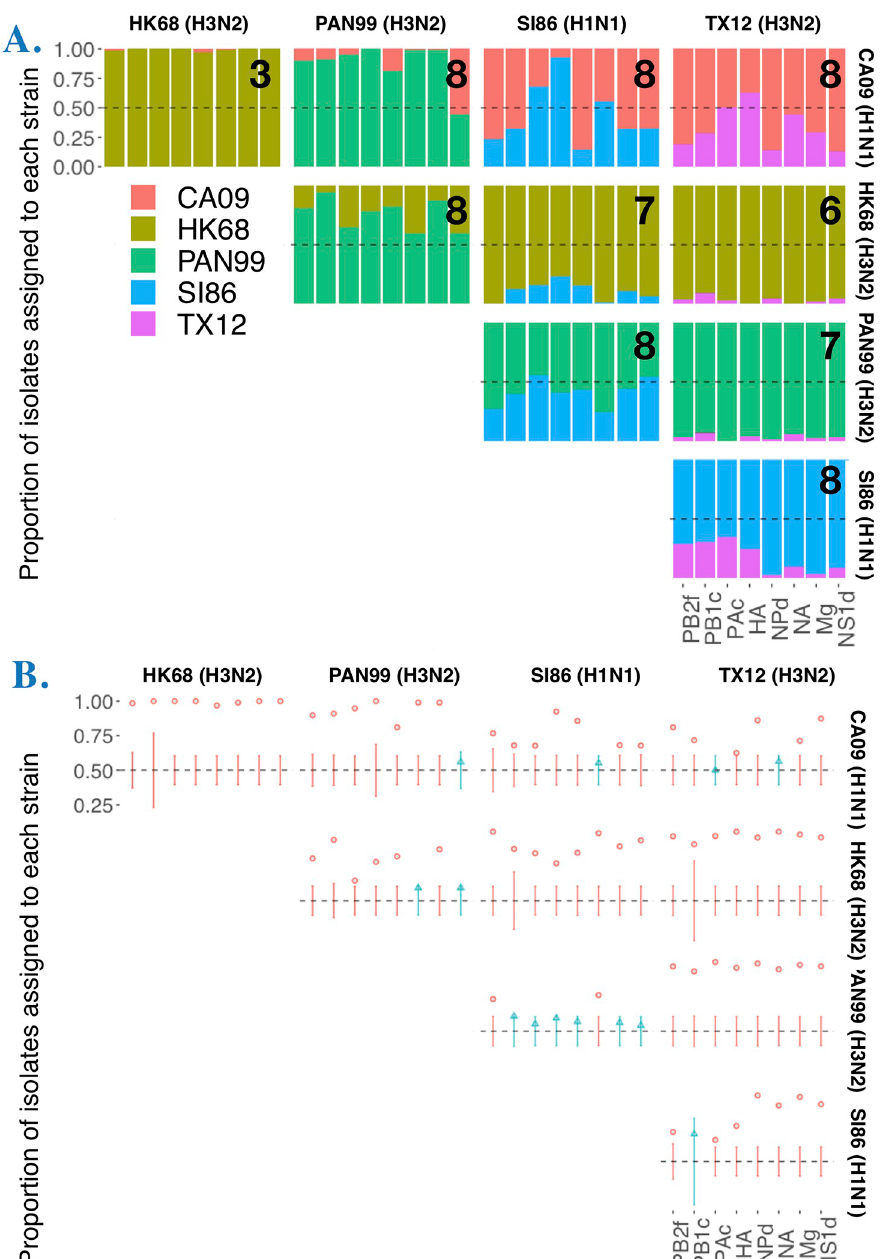
Fig 7. Many segments participate in genetic exchange and are non-randomly distributed in progeny plaque isolates with regard to strain. A. Plot shows frequency of each strain’s allele for each segment in plaque isolates. The number on the top right corner of each plot indicates the number of segments that participated in reassortment. B. Depicts which segment frequencies are within (blue points) or outside (red points) the confidence interval for 50:50 distribution of strain alleles among plaque